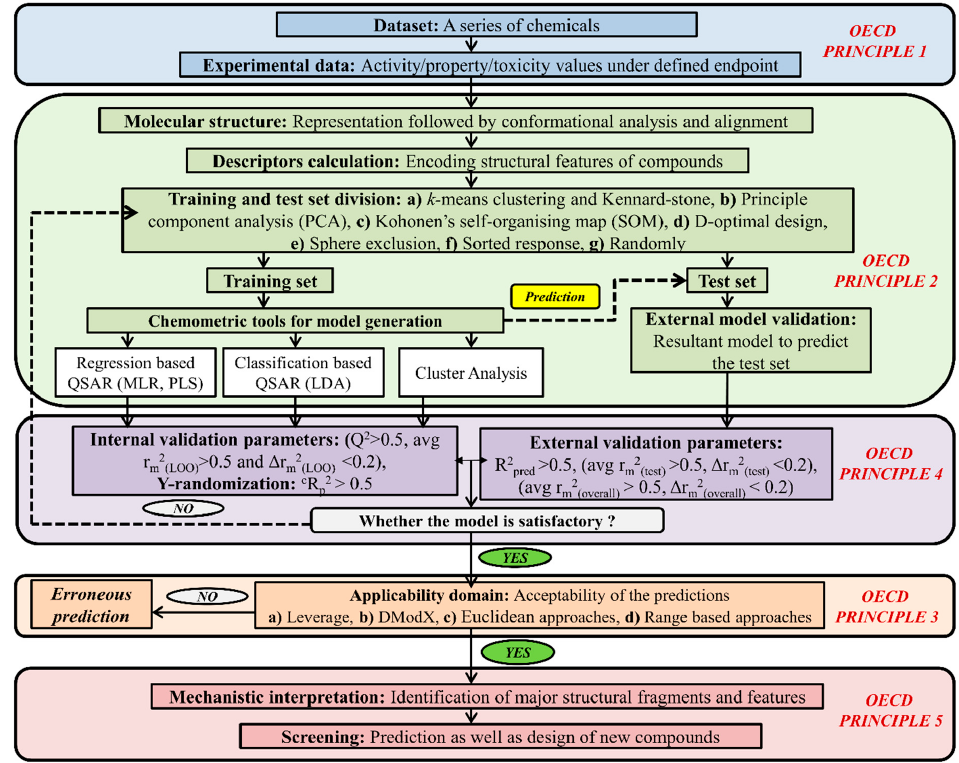
Figure 4. A complete schematic representation of the development of a QSAR model.